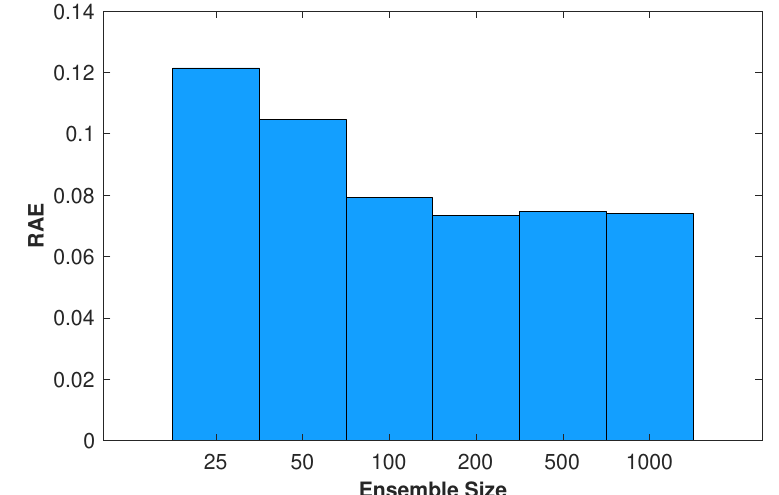
Figure 2. RAE of the viral load for Patient 1 for different ensemble